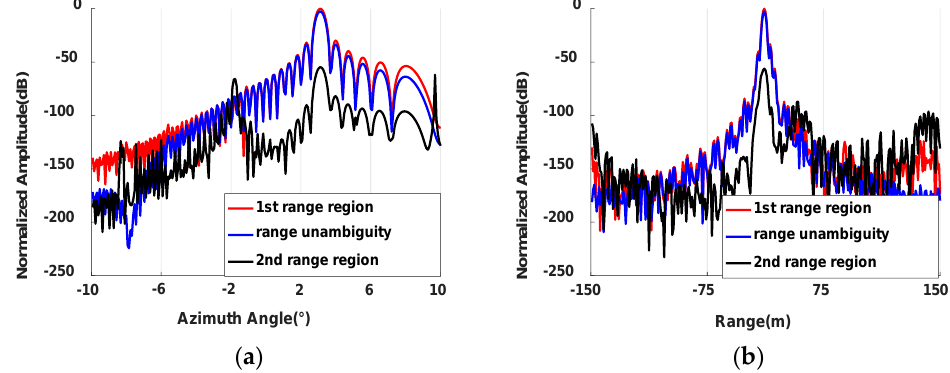
Figure 9. Amplitude comparison. ( a ) Amplitude comparison at the 150th range gate. ( b ) Amplitude comparison at the 164th azimuth gate.